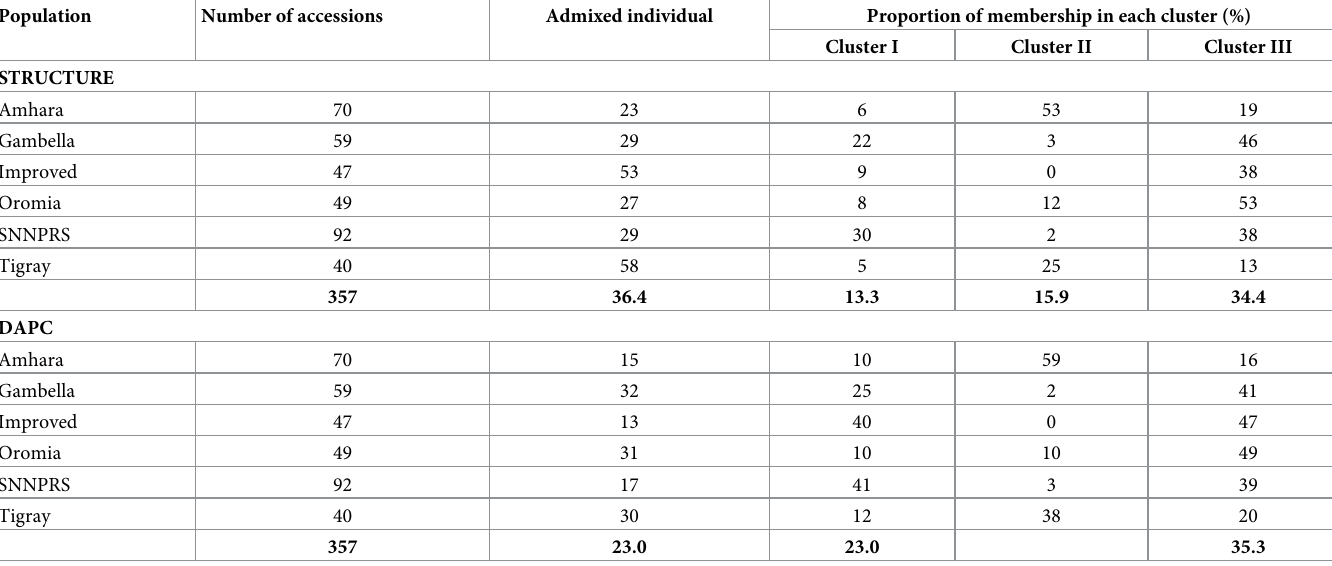
Table 3. Proportion of membership of each predefined population in each of the clusters obtained at the best K (K = 3). Population Number of accessions Admixed individual Proportion of membership in each cluster (%) Cluster I Cluster II Cluster